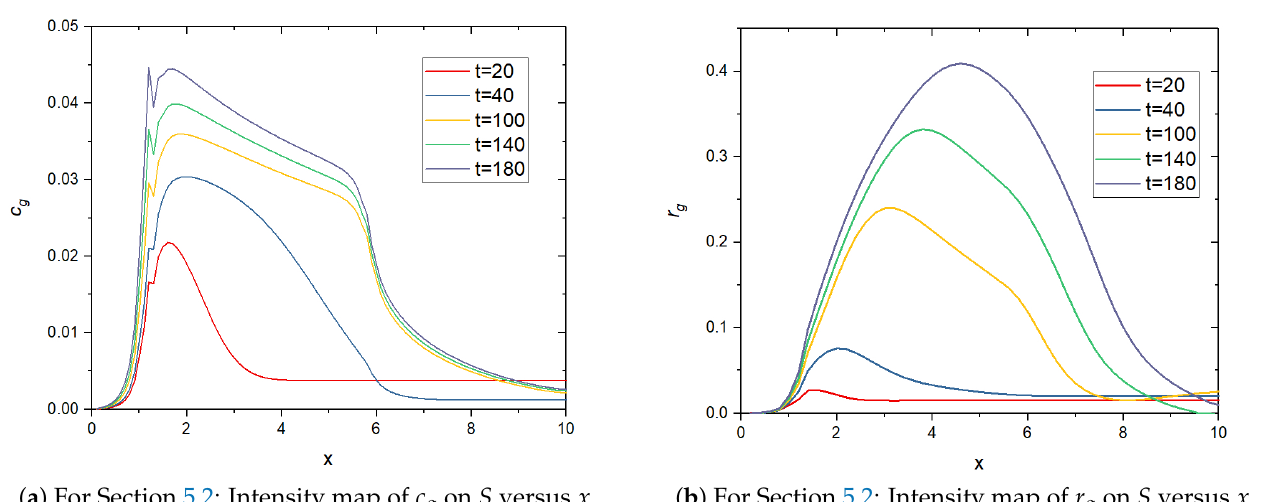
( a ) For Section 5.2: Intensity map of c g on S versus x . ( b ) For Section 5.2: Intensity map of r g on S versus x . Figure 3. Plots of r g and c g versus x on the reaction surface S . The gas bubble density in the plating reaction zone can be observed.